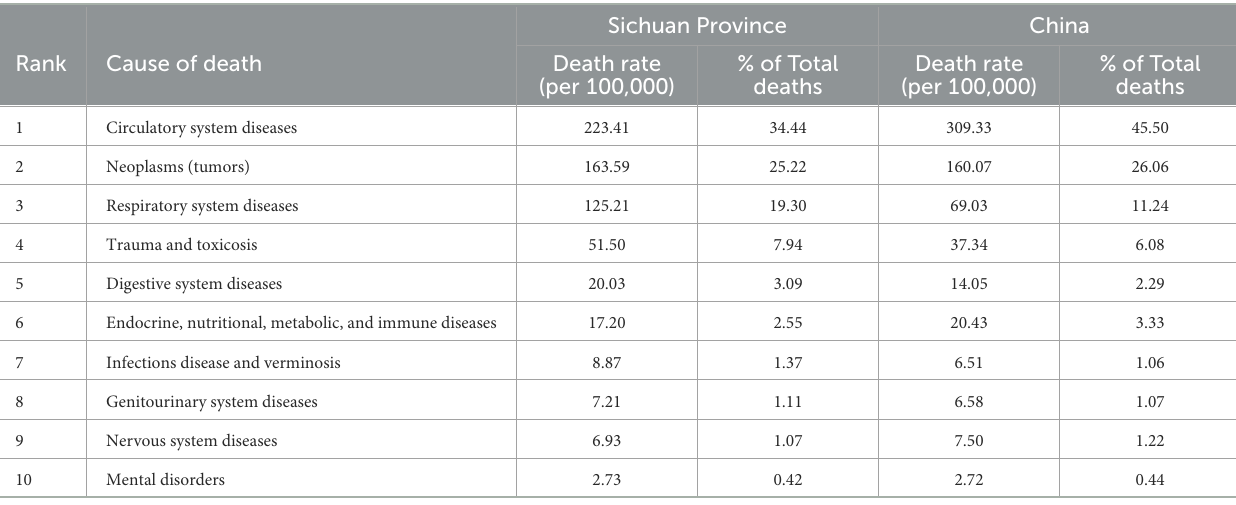
disease categories (Table 1): (1) circulatory system diseases